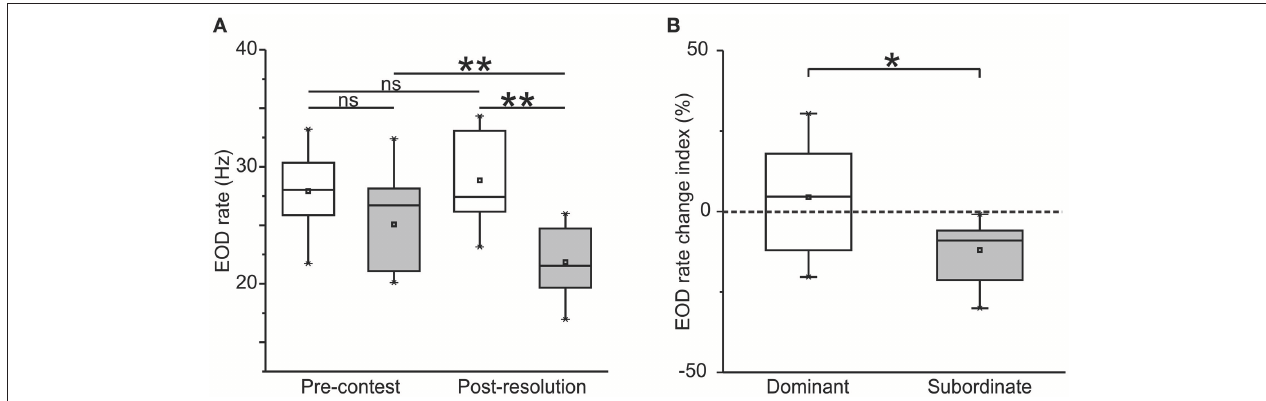
FIGURE 1 | Electric submission. (A) EOD rate of dominants (white) and subordinates (gray) in pre-contest and post-resolution phases of agonistic encounters. Pre-contest dominants vs. pre-contest subordinates, Mann–Whitney U -test, p = 0.15. Post-resolution dominants vs. subordinates, Mann–Whitney U -test, p = 0.0002. Pre-contest vs. post-resolution dominants, Wilcoxon paired test, p = 0.58. Pre-contest vs. post-resolution subordinates, Wilcoxon paired test, p = 0.001, n = 11 dyads. (B) EOD rate change index. Values around 0 (dotted line in graph) indicate no change in the EOD rate. Index values show a significant decrease in the EOD rate of subordinates whereas the EOD rate of dominants did not change. Index dominants vs. index subordinates, Mann–Whitney U -test, p = 0.03, n = 11 dyads. Box chart symbols: Mean (square), median (line in the middle), 25–75% interquartile range (lower and upper borders), minimum, and maximum values (lower and upper error bars). * p < 0.05; ** p < 0.01.